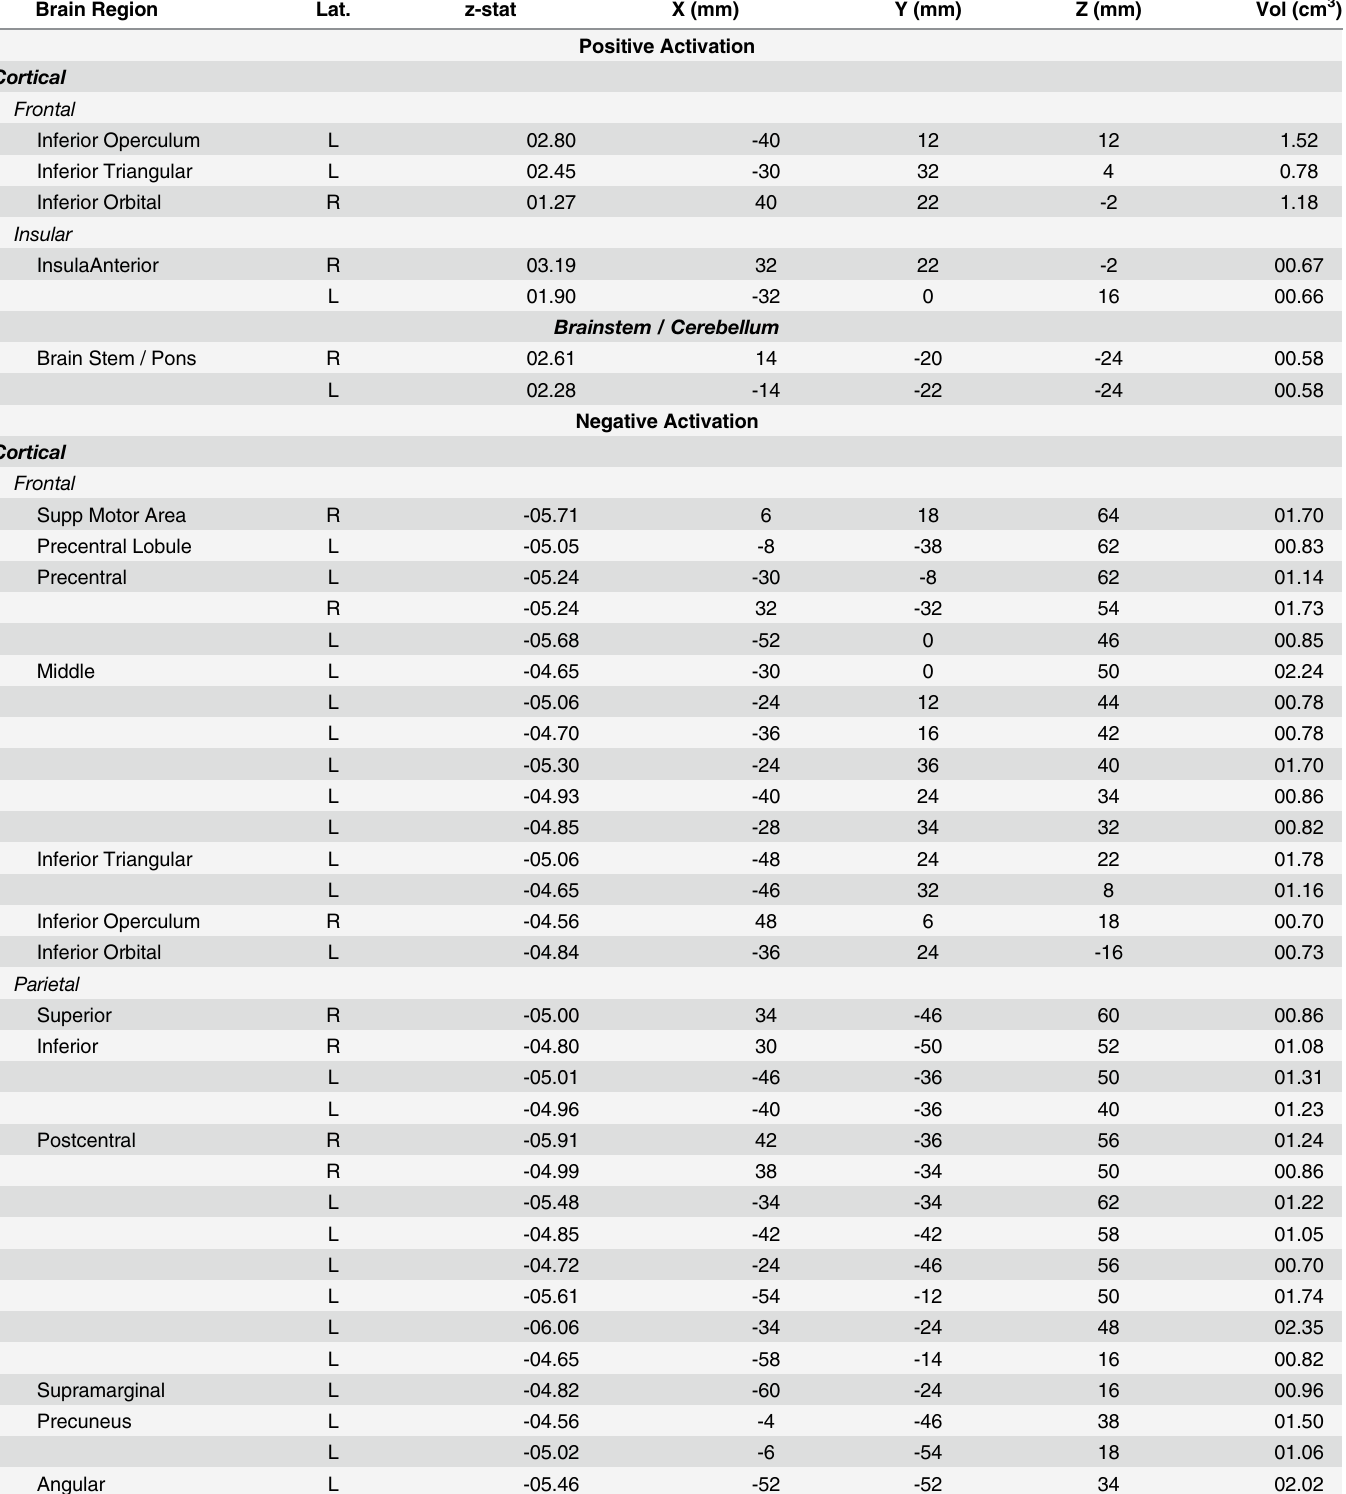
Table 3. Contrast analysis results for painful heat functional MRI activation after CGRP